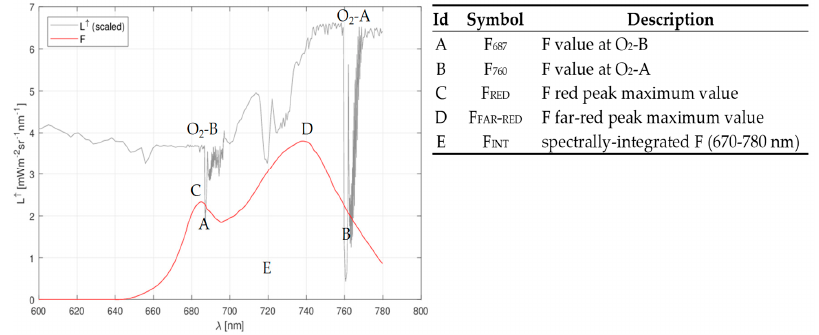
Figure 4. Fluorescence spectrum derived metrics.